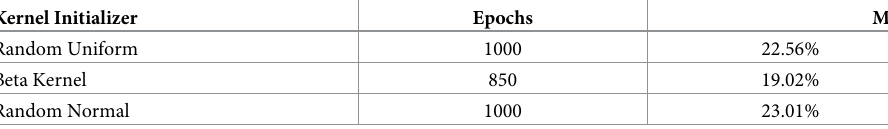
Table 10. Performance of different kernel